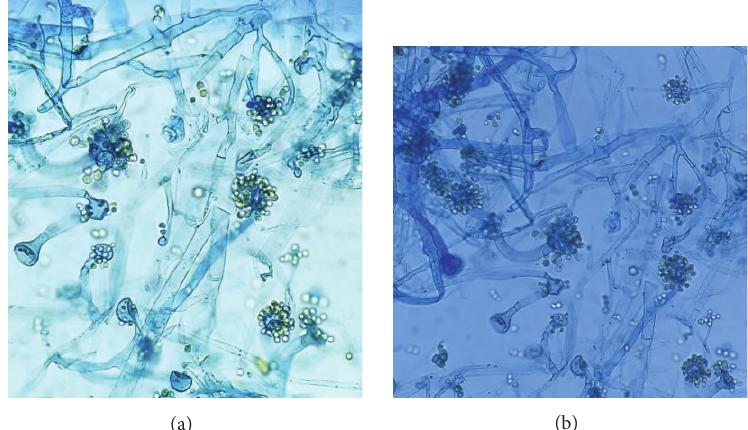
Figure 5: LPCB wet mounts showing branching sporangiophores with vesicles (roughly 32 𝜇 m), single-celled sporangiolum and sporangiospores attached to denticles and hyaline broad hyphae with 2-3 septae.